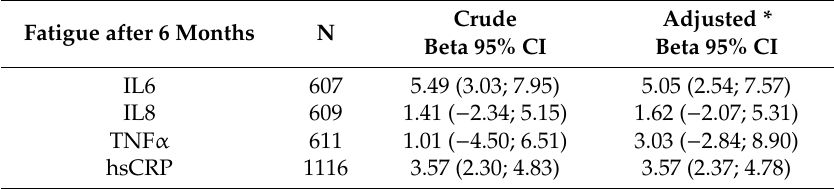
Table 3. The association between inflammation marker levels and fatigue six months after diagnosis.